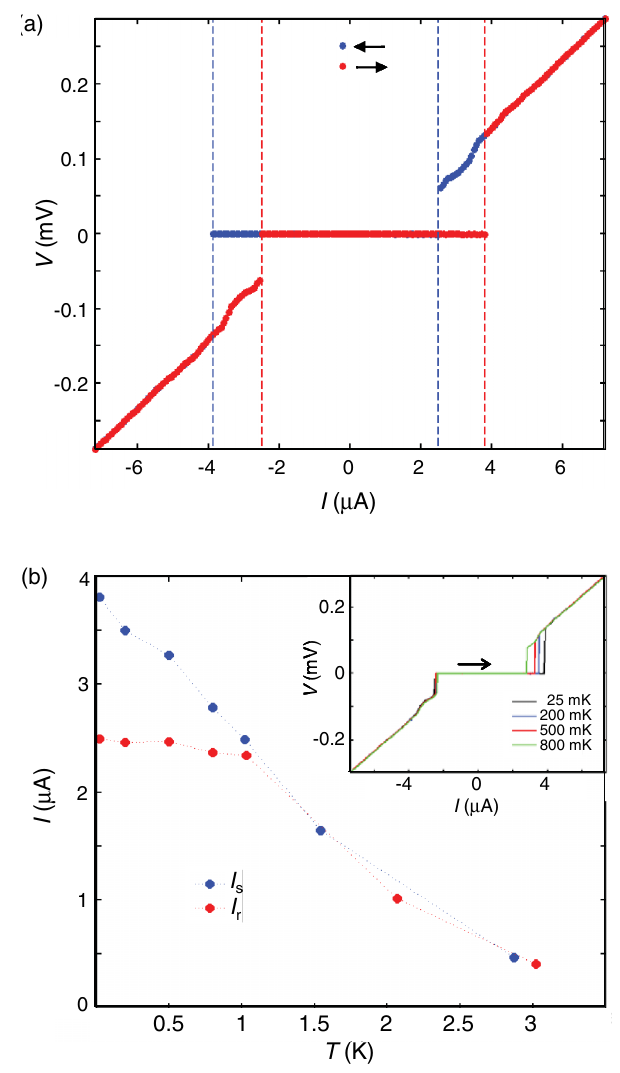
FIG. 3. (a) Ascending (red) and descending (blue) I - V char- acteristics, showing pronounced hysteresis ( T ¼ 25 mK ). The switching current, which is the critical current of the transition to the normal-state regime, is larger than the retrapping current, which is the critical current of the transition to the supercurrent regime. (b) The temperature dependence of the switching and retrapping current ( I s and I r ), showing that hysteresis is absent at T > 1 K . Note that the supercurrent regime disappears at T > 4 K . The inset shows hysteretic I - V characteristics in the temperature range of 25–800 is larger than the critical current corresponding to the transition from resistive to supercurrent regime—i.e., at T ¼ 25 mK , the switching and retrapping current are